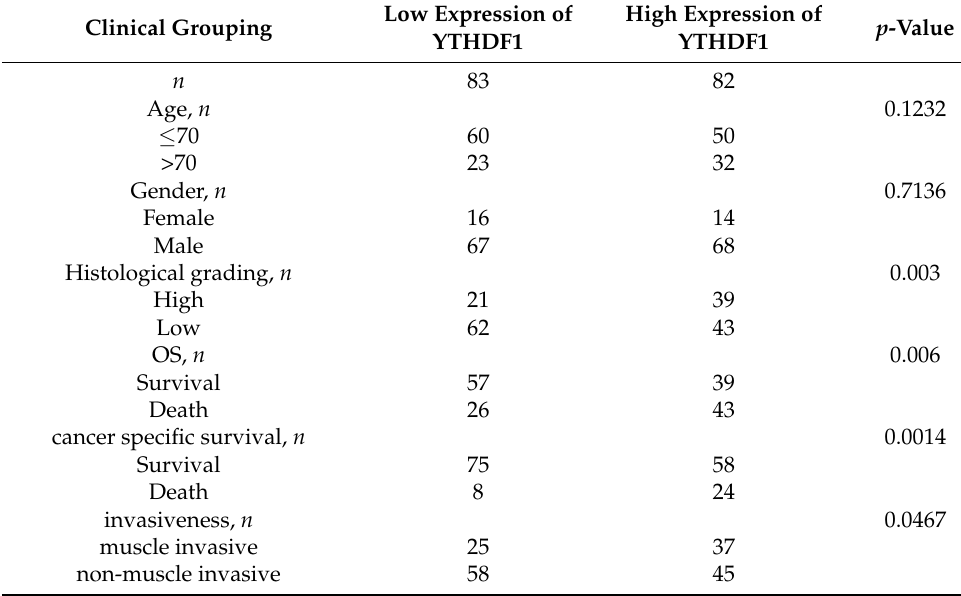
Table 1. Analysis of clinical characteristics of high and low YTHDF1 expression groups in the GSE13507